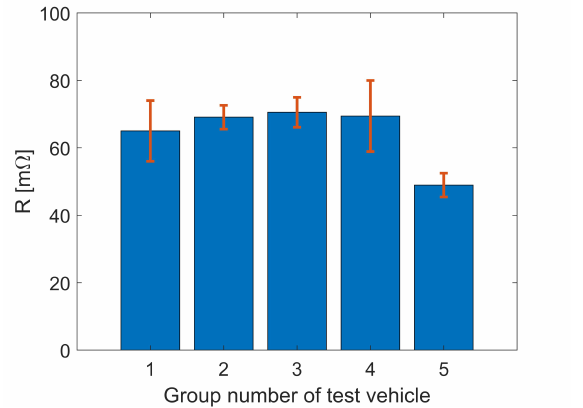
Figure 11. Average resistance of the conductive adhesive interconnection per test vehicle (error bars represent standard